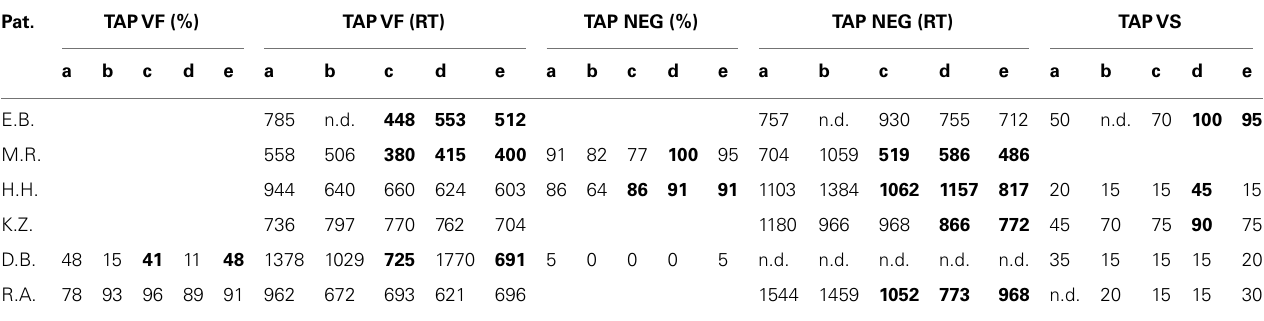
Table 3 | Results of computerized tasks.